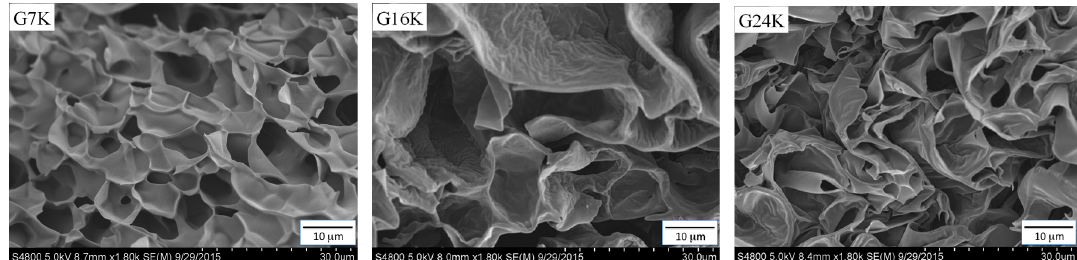
Figure 6 SEM photographs of freeze-dried gel samples. Figure 6. SEM photographs of freeze-dried gel